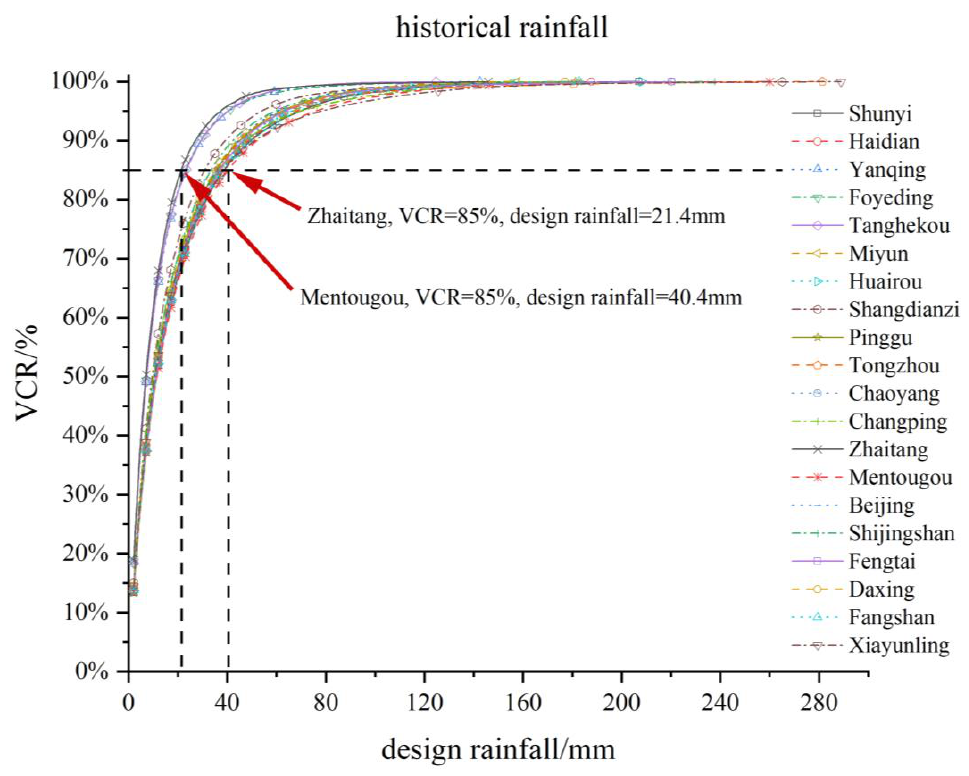
Figure 6. Correspondence between the VCR and the design rainfall in Beijing during historical periods. Table 3. The historical design rainfall under different VCRs (70 – 85%) at each station in Beijing.